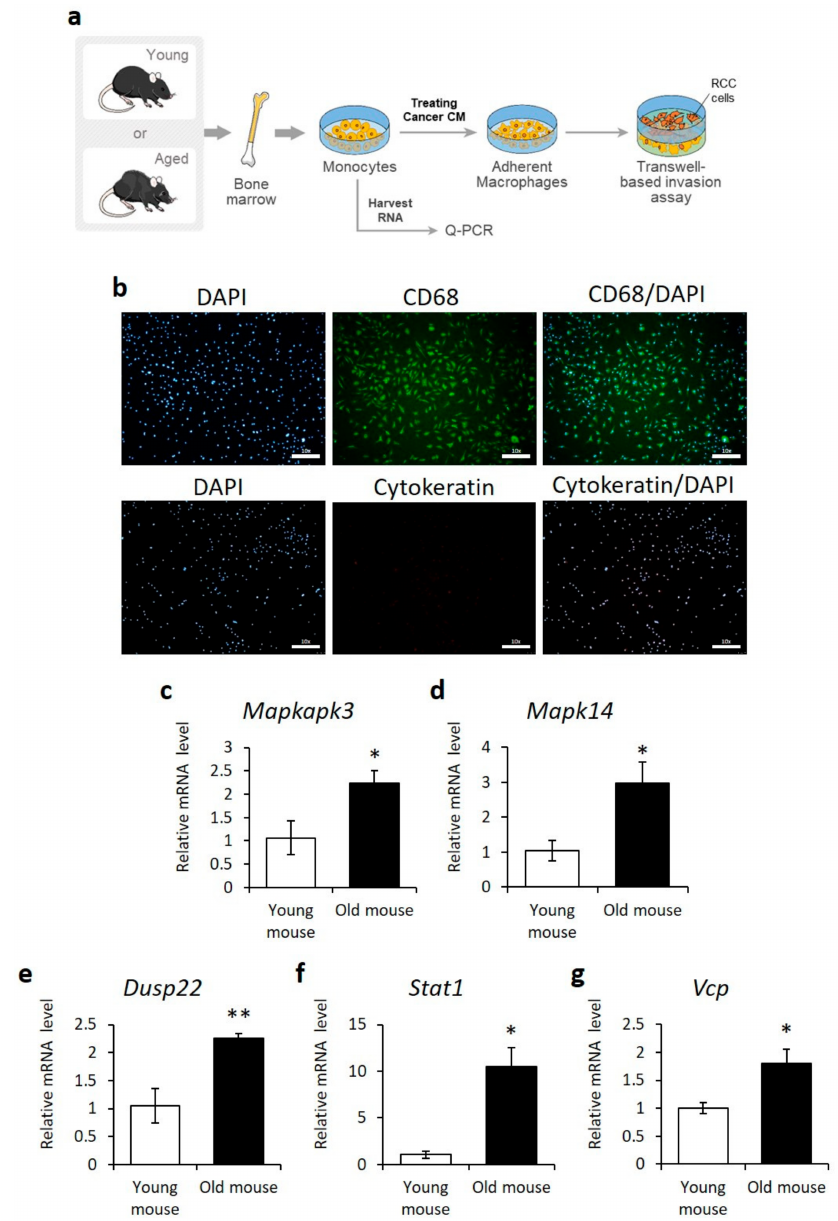
Figure 3. Upregulation of MAPKAPK3, MAPK14, DUSP22, STAT1, and VCP in the bone marrow- derived monocytes/macrophages of old mice. ( a ) Schematic diagram of the protocol assessing the aging-related genes in monocyte/macrophage derived from young or aged mice. ( b ) Immunofluo- rescence staining of CD68 and cytokeratin in primary bone marrow-derived macrophages differen- tiated by RENCA cell conditioned media. Nuclei were visualized using DAPI. Scale bar = 100 µ m. ( c – g ) qPCR analysis of MAPKAPK3 , MAPK14 , DUSP22 , STAT1 , and VCP gene expression in primary bone marrow-derived monocytes isolated from young (5-week-old) or old (72-week-old) mice. n = 3, Error = SE, * = p -value < 0.05, ** = p -value < 0.01 compared to young